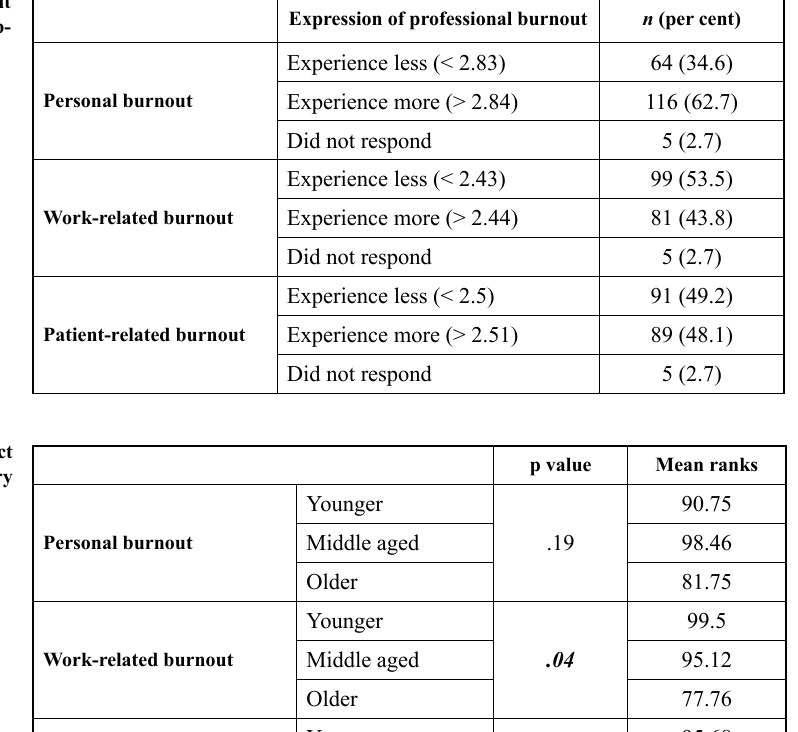
Table 6. Distribution of Copenhagen Burnout Inventory Subscale expression among sub - jects